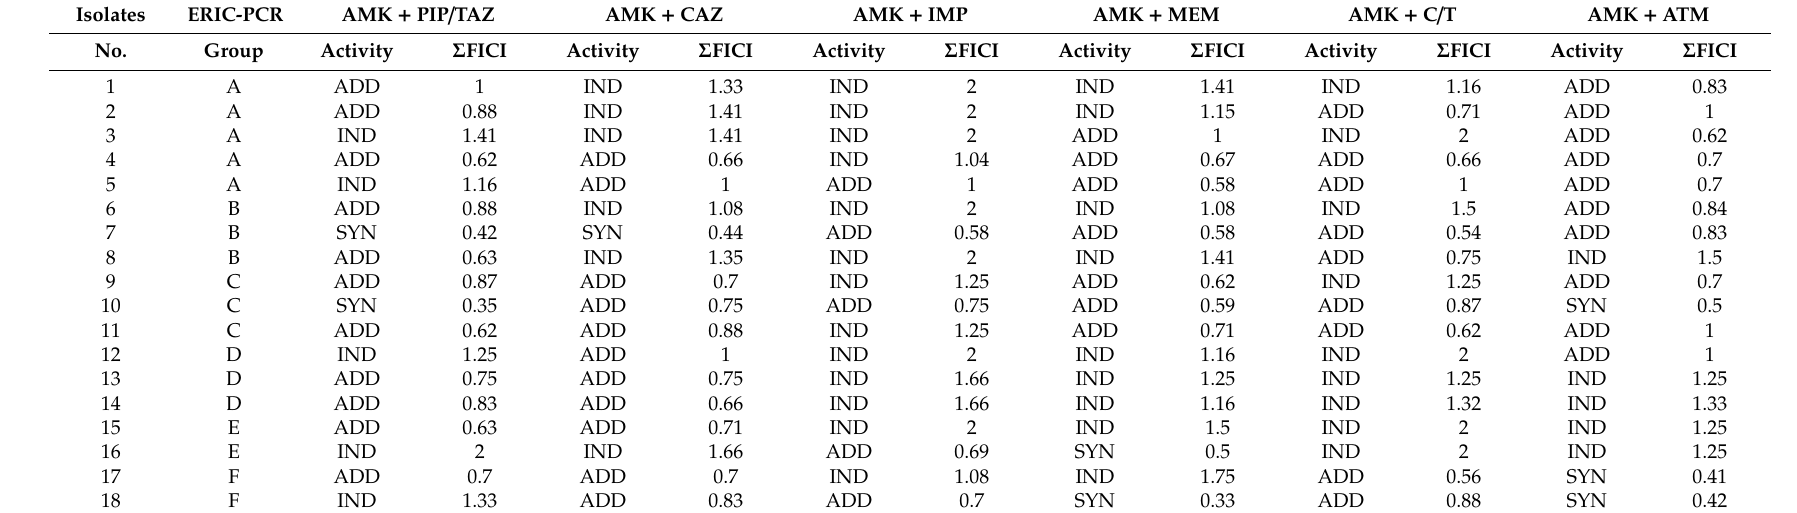
Table 2. Clonal relationship and antimicrobial combinations of colistin-resistant P. aeruginosa